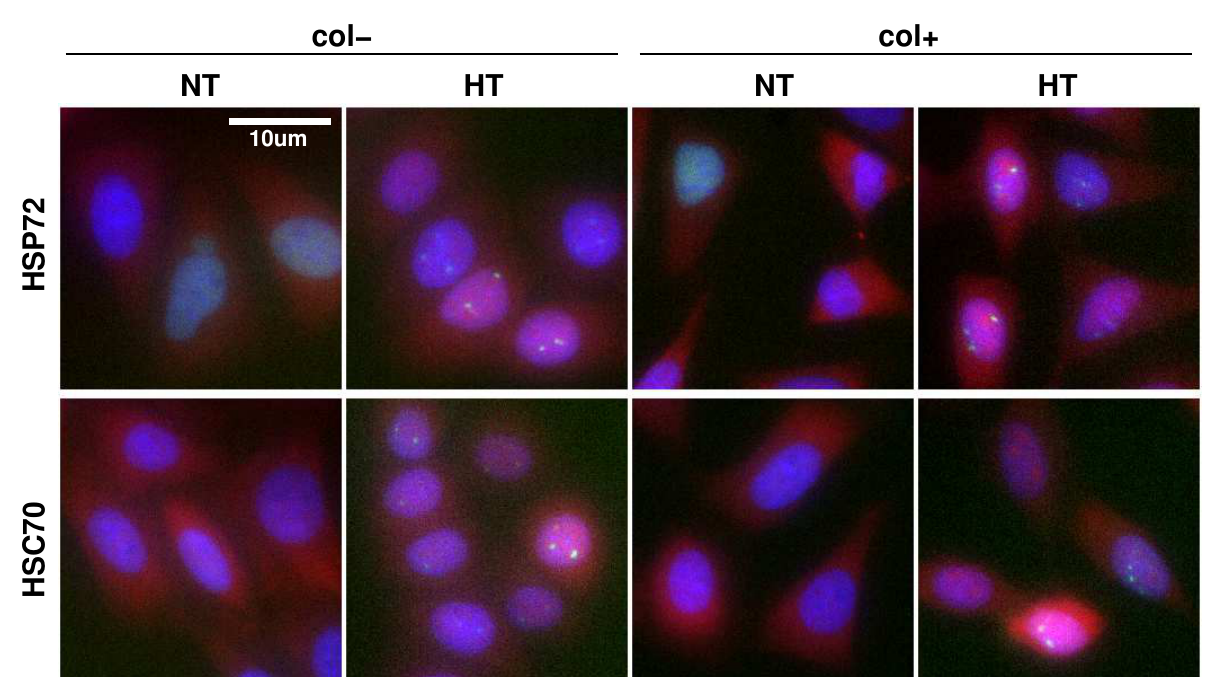
Figure 1. Immunofluorescence staining of HSPs and HSF1. HeLa-HSF1:eGFP cells exposed to normothermia (NT) at 37 ◦ C or hyperthermia (HT) consisting of a one hour at 43 ◦ C for two different culture conditions: with collagen coating (col+) or not (col − ). HSP (red channel), HSF1:eGFP (green channel), Hoechst (blue channel). In HT, bright green spots localized in the nucleus correspond to HSF1 foci. Scale bar: 10 µ